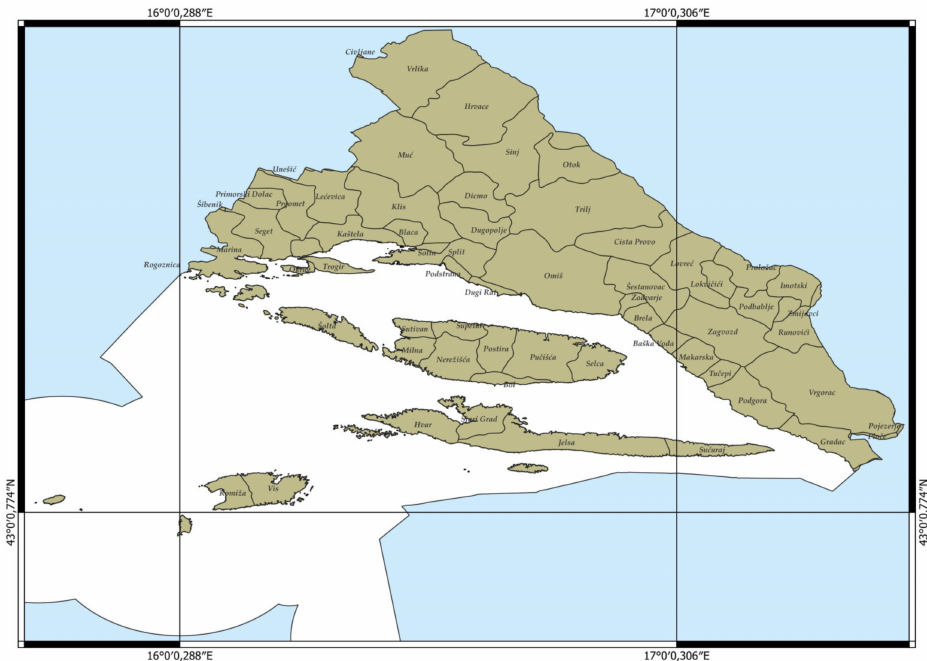
Figure 3. Map of Split-Dalmatia